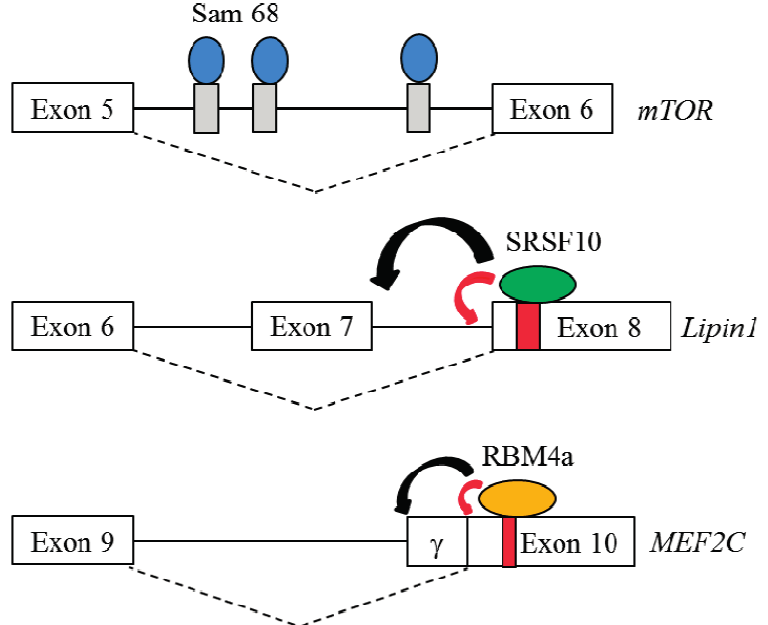
Figure 2. Schematic diagram represents the underlying mechanism for Sam68, SRSF10 and RBM4a-regulated AS events during adipogenesis. Blue ovals represent Sam68 proteins. Green ovals represent SRSF10 proteins and orange ovals represent RBM4 proteins; Gray and red rectangles represent the binding elements of Sam68, SRSF10 and RBM4; Red arrowhead represents the activation of splice site, whereas black arrowhead represents the repression of splice